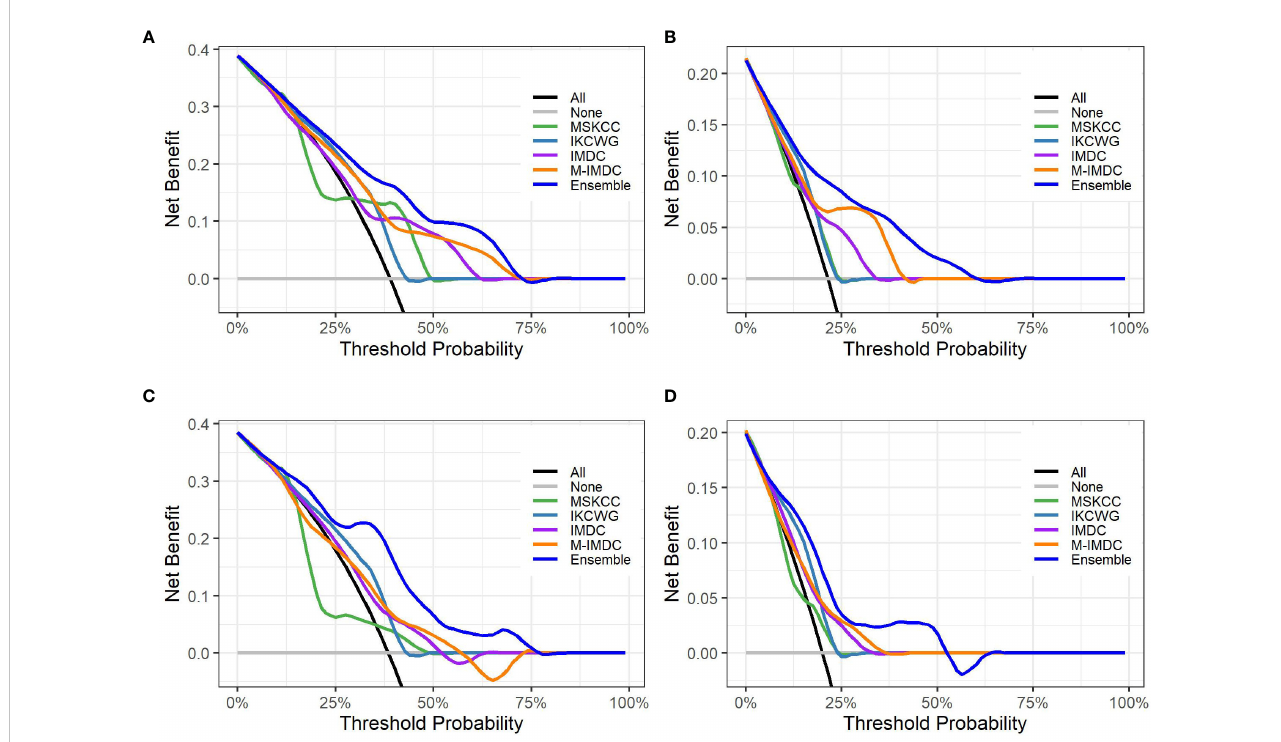
FIGURE 5 Decision curve analysis graphs showing the net bene fi t produced by the models across all threshold probabilities. The depicted curves were obtained using predictions of the ensemble model compared with well-known prognostic models, as well as two additional curves that were based on two types of extreme decisions: curves referred to as ‘ All ’ represent the prediction that all patients would die in three to fi ve years after treatment start. The curve referred to as ‘ None ’ represents the prediction that all the patients would be alive in three to fi ve years after treatment starts. (A, B) show the decision curves of predictive models for the cross-validation set for three- and fi ve-year OS, respectively. (C, D) show the decision curves of predictive models for the hold-out set for three- and fi ve-year OS, respectively. The decision curve indicates that the ensemble model has a higher bene fi t than the prediction that all patients will die, or none will die; it is higher than all well-known models for the reasonable range of thresholds.